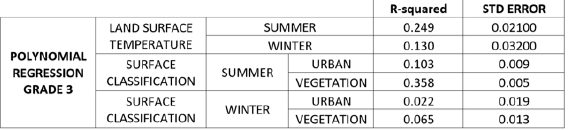
Figure 28: Land Surface Temperature in summer